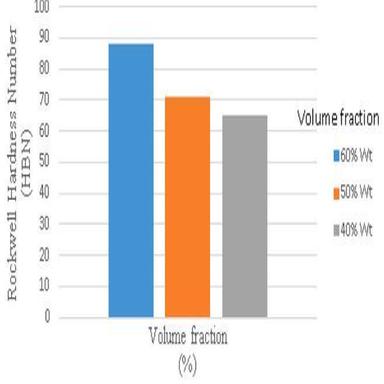
The effect of Rockwell Hardness number on the volume Fraction of Citrus limetta peel powder composites.